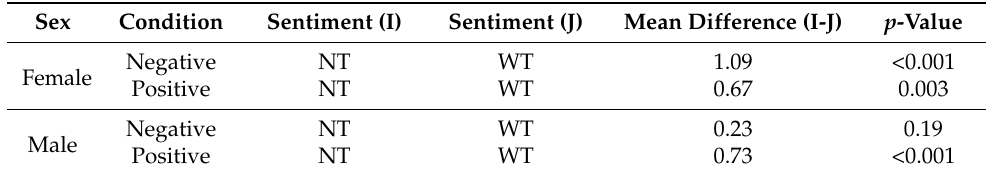
Table 10. Sex Comparison Between Physiological Arousal Change in Positive and Negative Utter- ances by Touch